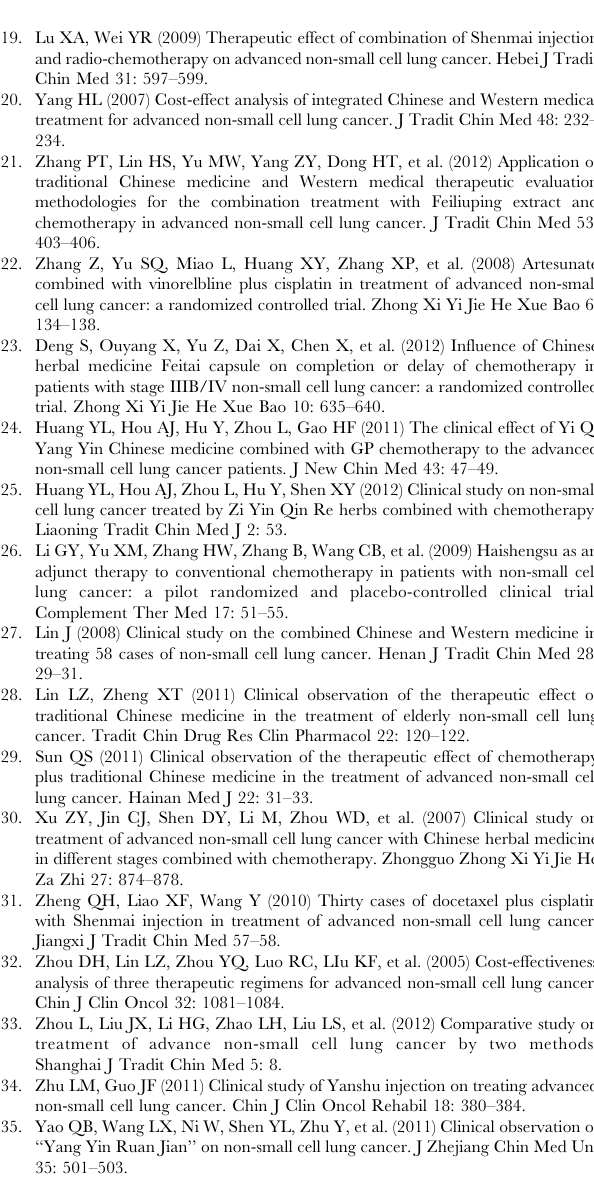
Figure S1 Number of patients with survival . half-year. Overall survivals estimated from meta-analysis of pairwise comparisons in the patients with chemotherapy combined Chinese herbal medicine (CTC, treatment group) versus patients in chemotherapy (CT, control group). Table S1 The risk of bias of the included studies. Table S2 Age, gender and baseline of